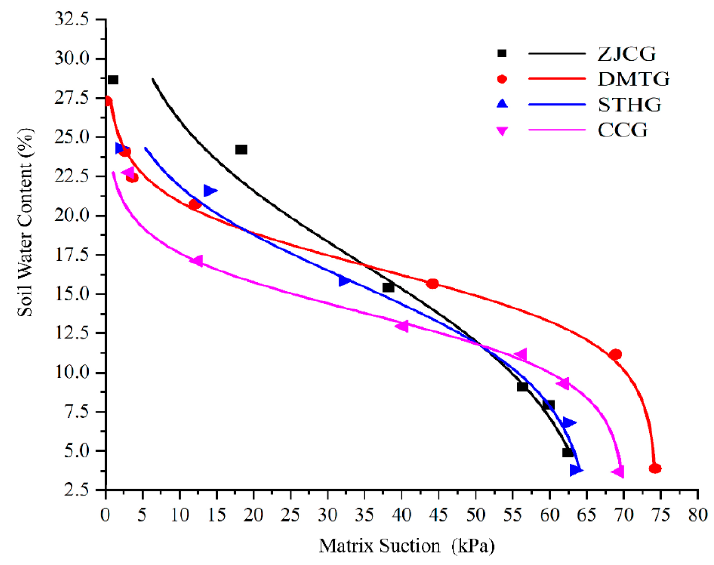
Figure 16. SWCCs of soil samples.